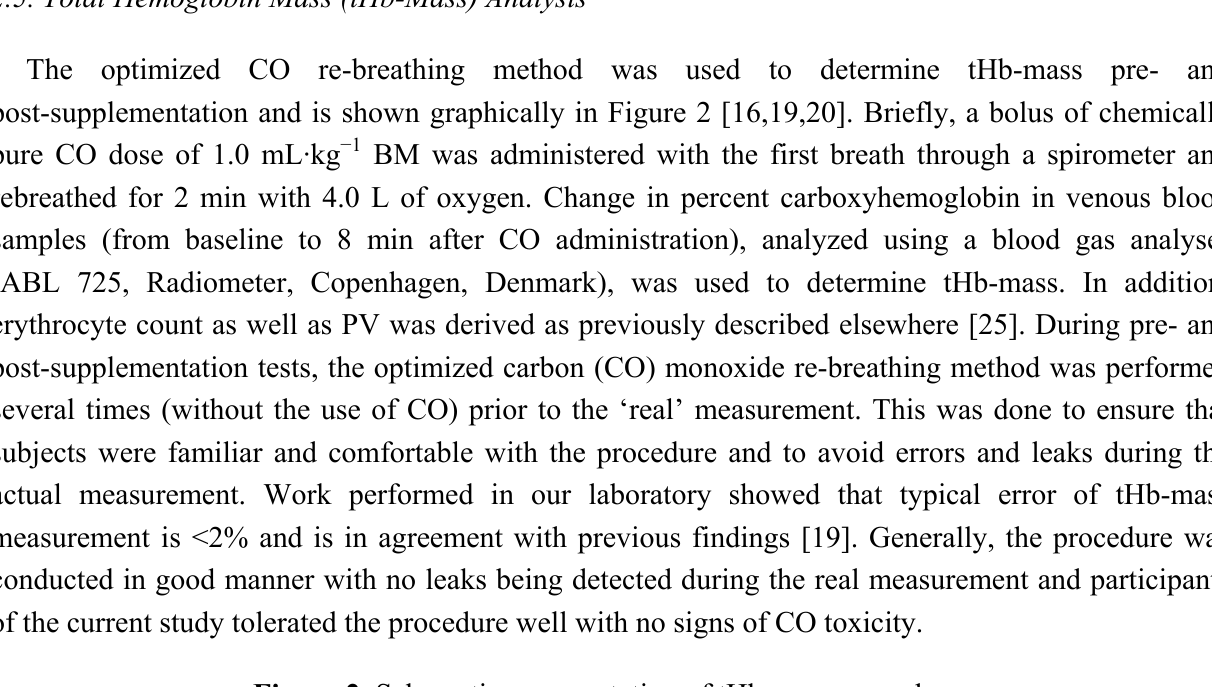
Figure 2. Schematic representation of tHb-mass